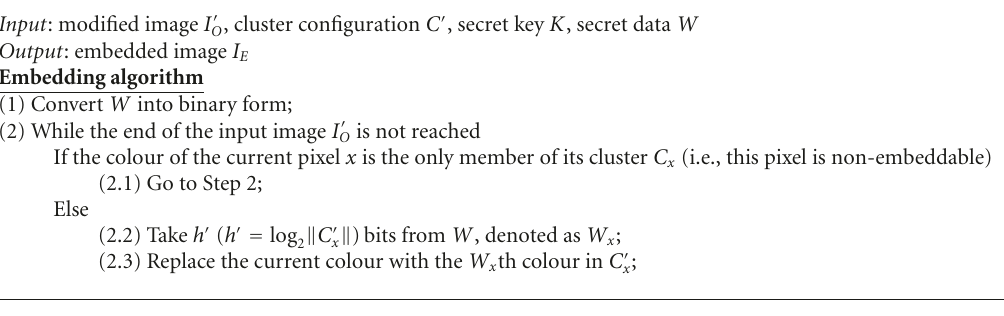
Algorithm 3: Data hiding algorithm.